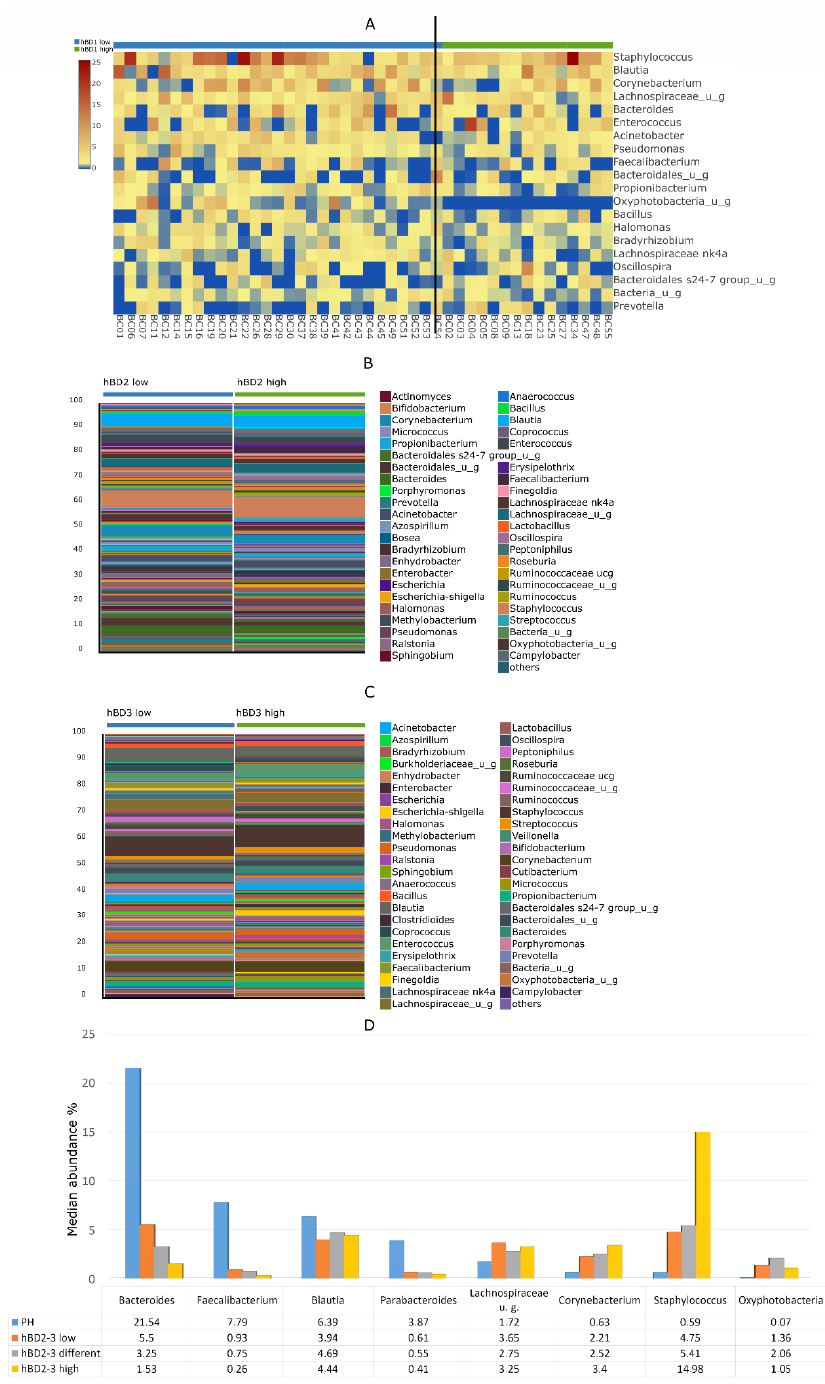
Figure 5. Correlation between the amount of defensins in urine and the abundance of the charac- teristic genera in BC tissue microbiome. ( A ) Oxyphotobacteria is the only genus whose occurrence differs significantly from the quantitative change in HBD1, Oxyphotobacteria is present only at low HBD1 levels. There is no significant difference due to the amount of ( B ) HBD2 or ( C ) HBD3 alone in the abundance of the genera in the BC tissue microbiome. ( D ) The combined increase in HBD2 and HBD3 levels reduces the abundance of non-tumor specific genera (Bacteroides, Parabacteroides, Fae- calibacterium) and increases the abundance of more common in-tumor tissue genera (Staphylococcus,